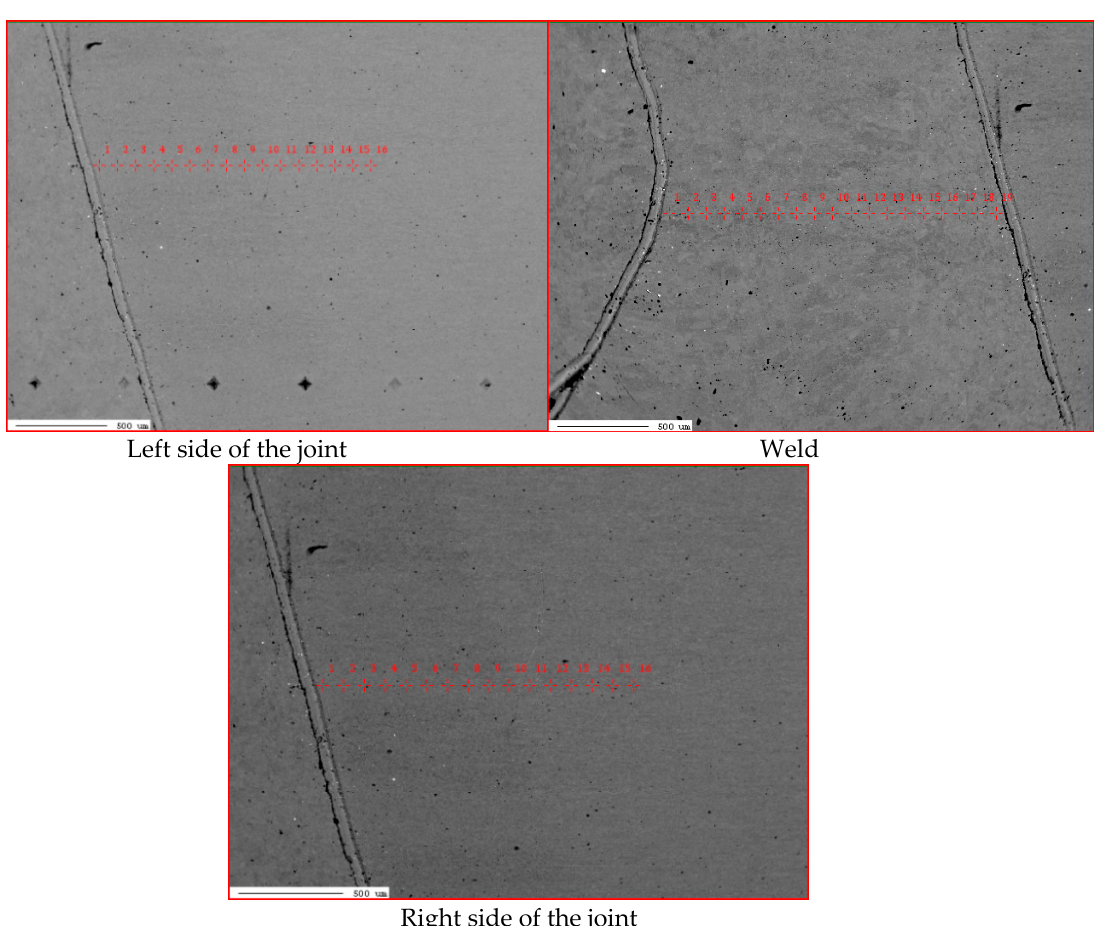
Figure 15. Points of quantitative composition measurements performed using the X-ray microanalyser and wavelength dispersion spectroscopy (WDS) for a laser welded joint in the PC position with 5 kJ/cm linear energy.